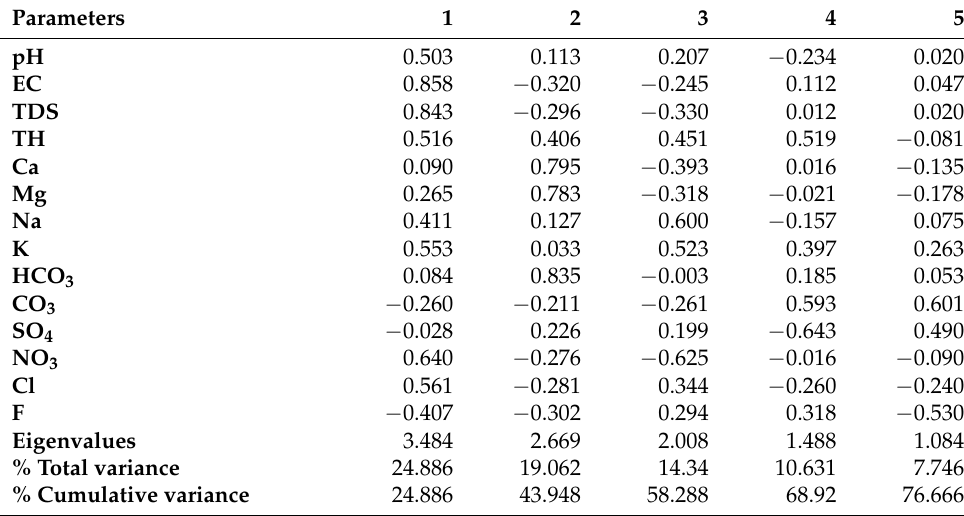
Table 5. The findings of Principal Component Analysis